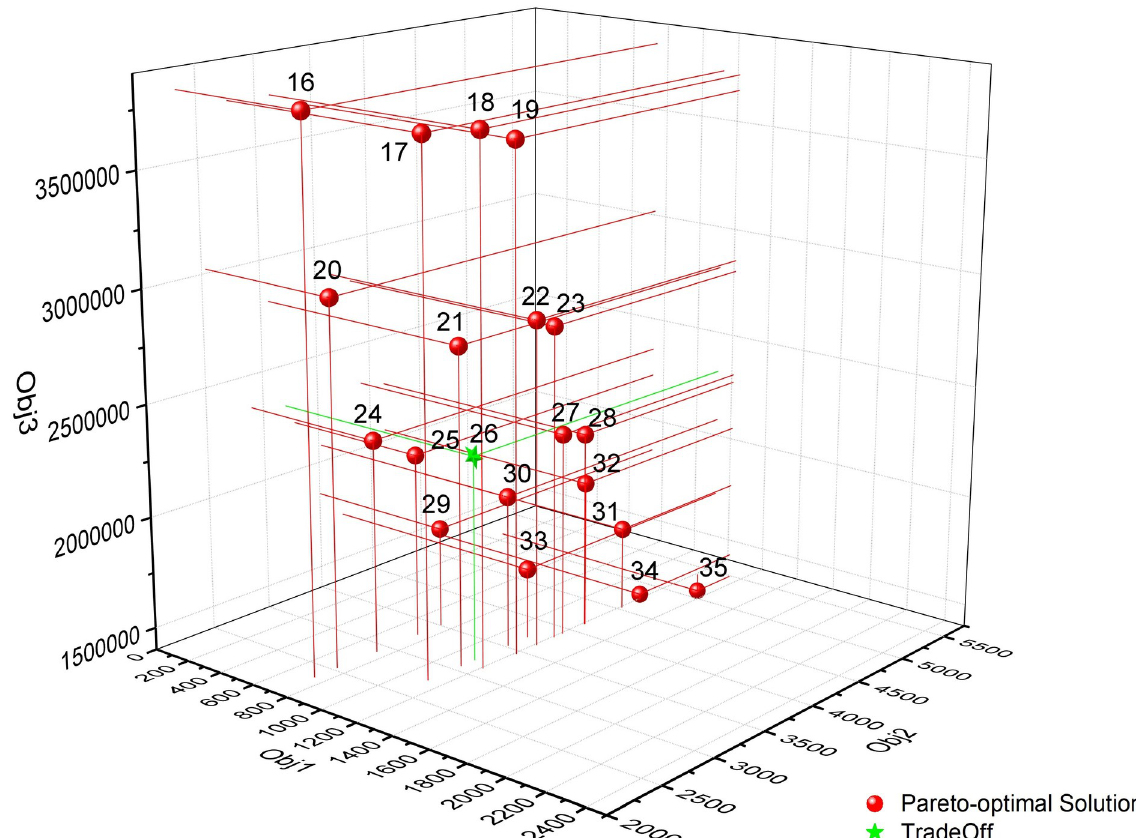
Fig 5. The distribution of the Pareto optimal solution of Model 2 in the three-dimensional coordinate system (p = 2).